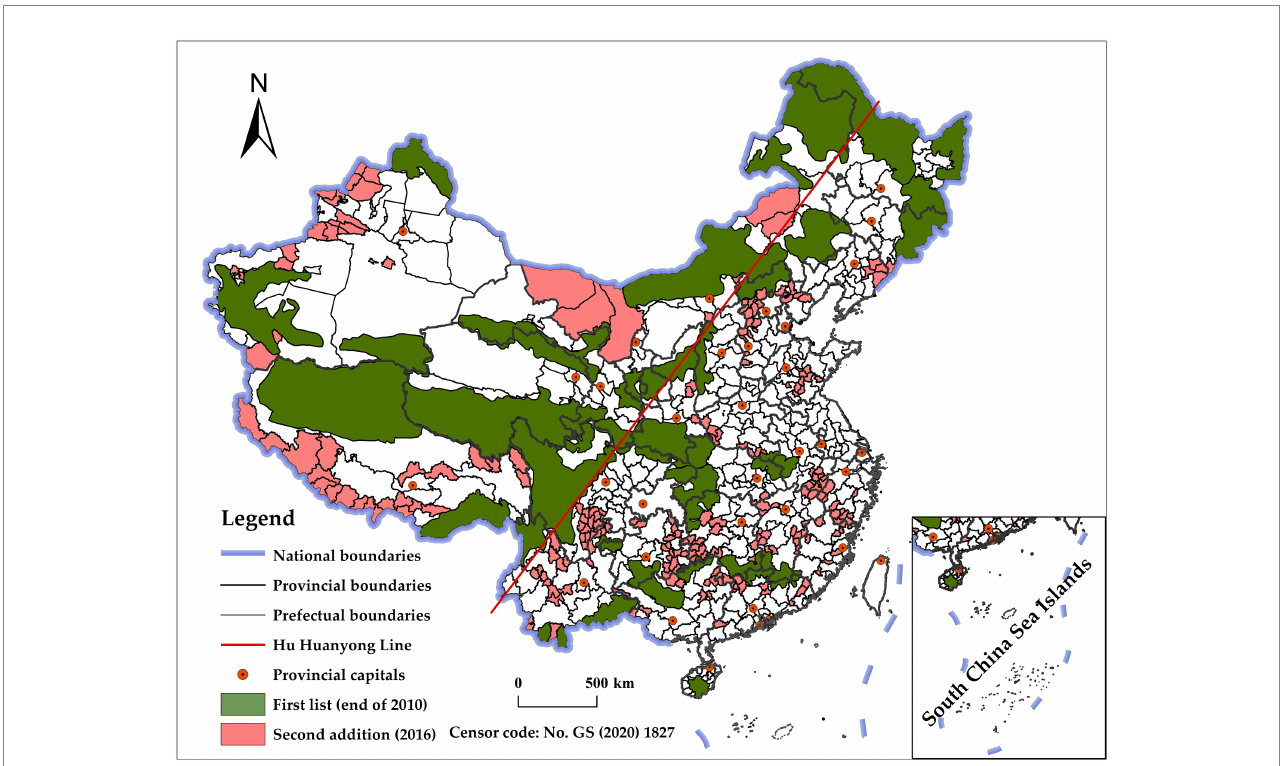
FIGURE 1 The distribution map of